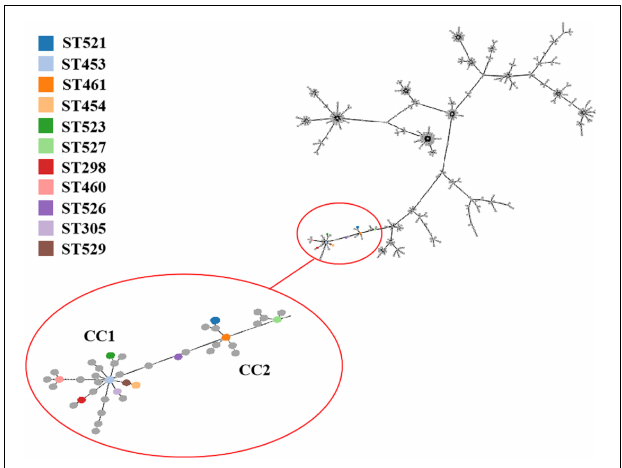
FIGURE 2 | Minimum spanning tree (MST) of MLST for Streptococcus dysgalactiae (including Streptococcus dysgalactiae subsp. equisimilis and subsp. dysgalactiae ) involving 445 STs in MLST database performed by geoBURST algorithm and visualized by PhyloViz online. The STs identified in this study were in various colors, whereas remaining STs in the MLST database were gray. Cloning complexes (CCs) were defined as groups of similar isolates, each isolate having at least 5 of 7 identical alleles with at least 1 other ST within the group. ST453, ST305, ST523, ST454 and ST529 were grouped into CC1, and ST453 was the main evolutionary starter. ST461, ST521 and ST527 were grouped into CC2, whereas ST460, ST298, and ST526 were considered 3